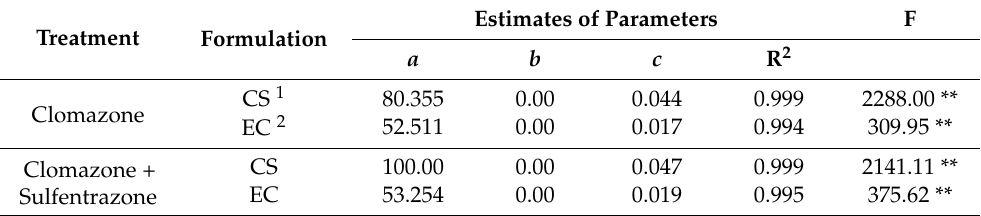
Table 3. Estimates of parameters of Mitscherlich models fitted for correlation of quantity of clomazone percolated through sugarcane straw with different simulated rainfall depths (mm), after application of different formulations (single or combined with sulfentrazone). Estimates of Parameters F Treatment Formulation a b c R 2 CS 1 80.355 0.00 0.044 0.999 2288.00 ** Clomazone EC 2 52.511 0.00 0.017 0.994 309.95 ** CS 100.00 0.00 0.047 0.999 2141.11 ** Clomazone + EC 53.254 0.00 0.019 0.995 375.62 Sulfentrazone